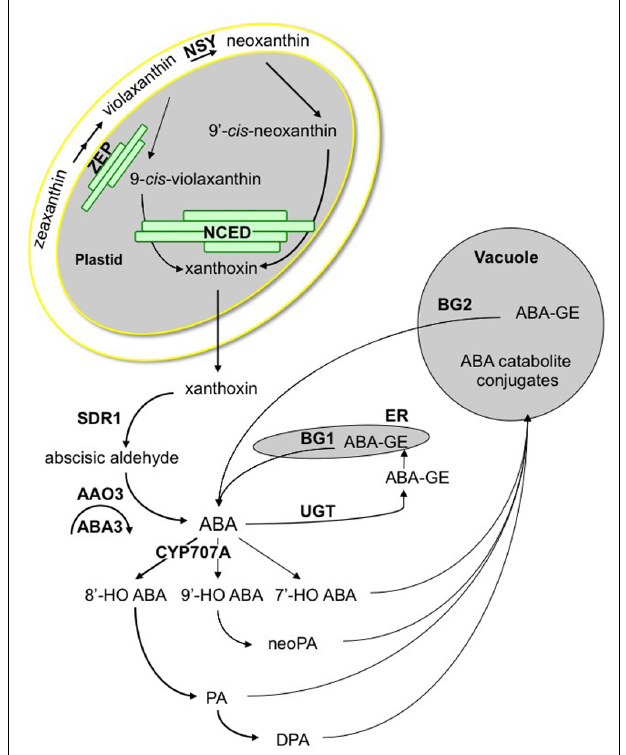
FIGURE 1 |ABA metabolism pathway. Zeaxanthin conversion into violaxanthin is catalyzed by zeaxanthin epoxidase (ZEP). ABA4 is involved in the synthesis of neoxanthin, which is then cis -isomerized, together with violaxanthin, by an unknown isomerase. Carotenoid cleavage is catalyzed by a family of 9- cis -epoxycarotenoid dioxygenases (NCED) to form xanthoxin. Xanthoxin moves to the cytosol by an unknown mechanism and is converted into abscisic aldehyde by a short-chain dehydrogenase reductase (SDR1), which is then oxidized into ABA by an abscisic aldehyde oxidase (AAO3). Sulfuration of AAO3 molybdenum co-factor by ABA3 is necessary for enzyme activity.The 8 (cid:2) -hydroxylation by CYP707A enzymes is thought to be the predominant pathway for ABA catabolism. Hydroxy-groups of ABA and its catabolites, phaseic acid (PA), neoPA, and dihydrophaseic acid (DPA) are targets for conjugation. ABA-glucose ester is formed by ABA glucosyltransferases (UGT) and hydrolyzed by glucosidases, including BG1 and